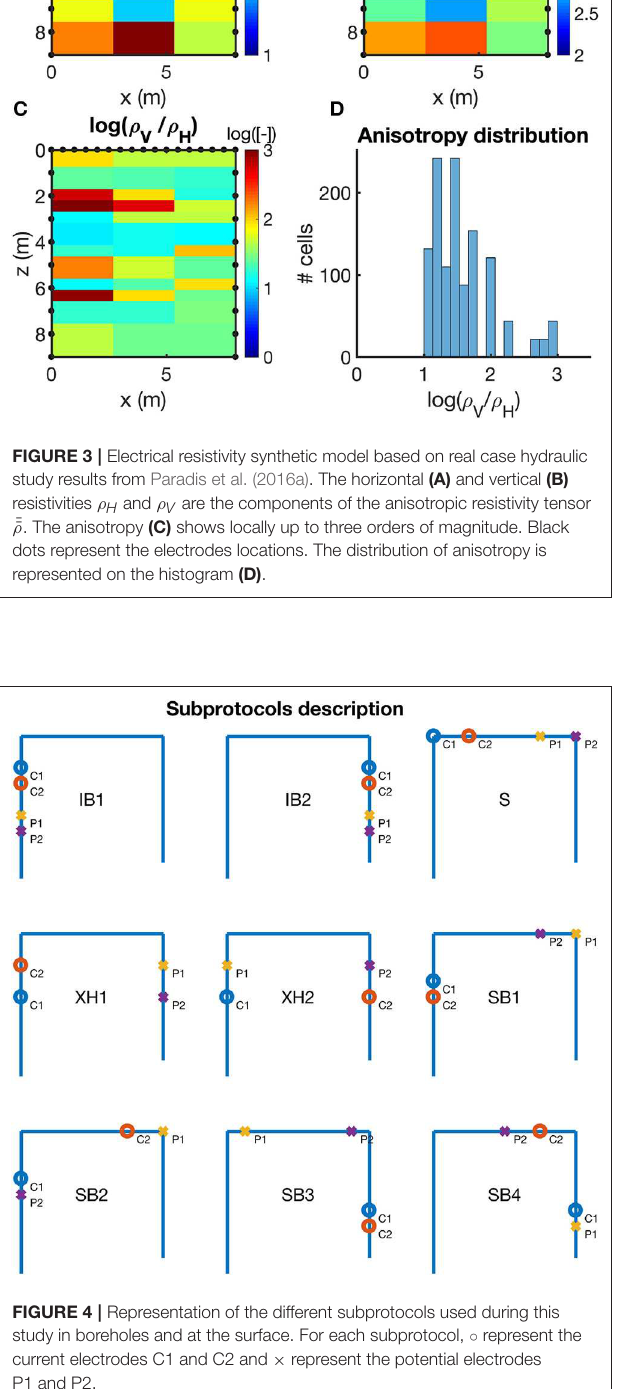
represent the ◦ represent the potential electrodes ×